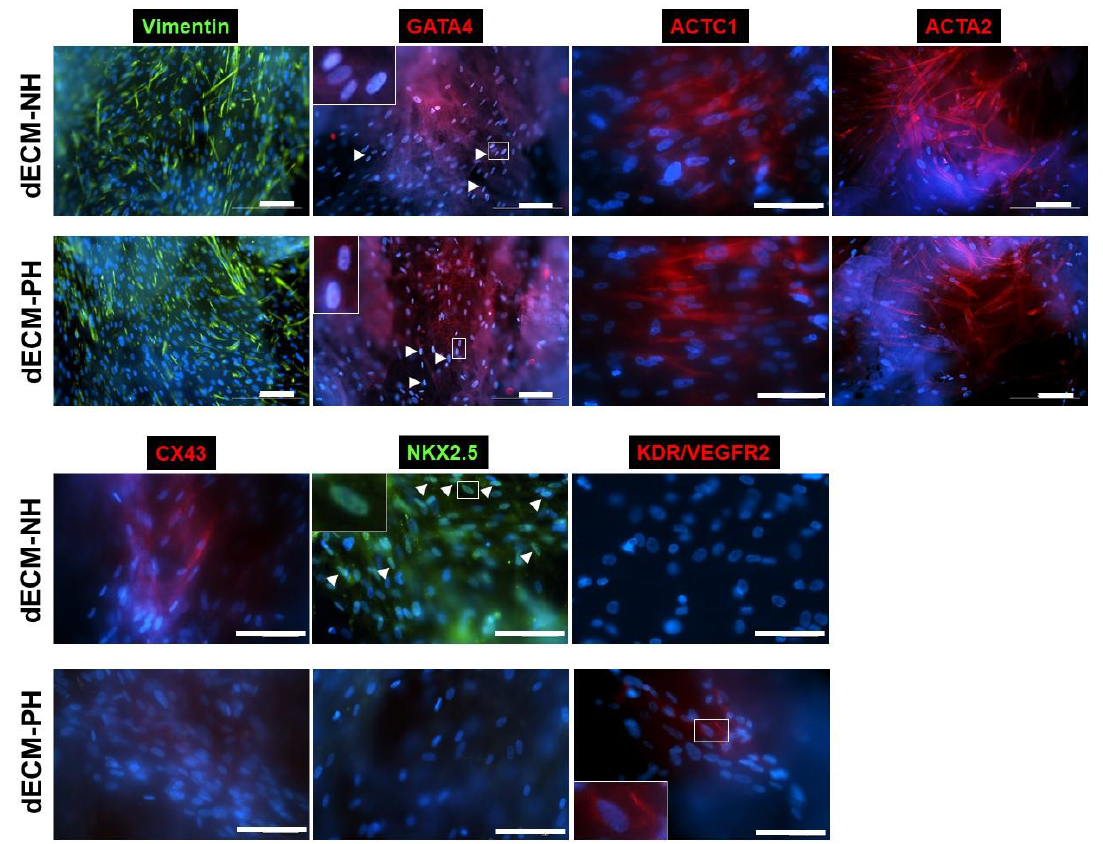
Figure 3. Immunofluorescence analysis of CPCs seeded on dECMs. Representative fluorescence microscope images of stained CPCs cultured for 1 week on normal (NH) or pathological (PH) dECMs. Inserts in panels show higher magnification details. Scale bars = 100 µ m. ACTC1: cardiac muscle alpha actin. ACTA2: smooth muscle alpha ( α )-2 actin. CX43: connexin 43. NKX2.5: NK2 Homeobox 5. KDR: kinase insert domain receptor. Arrowheads: transcription factor-positive